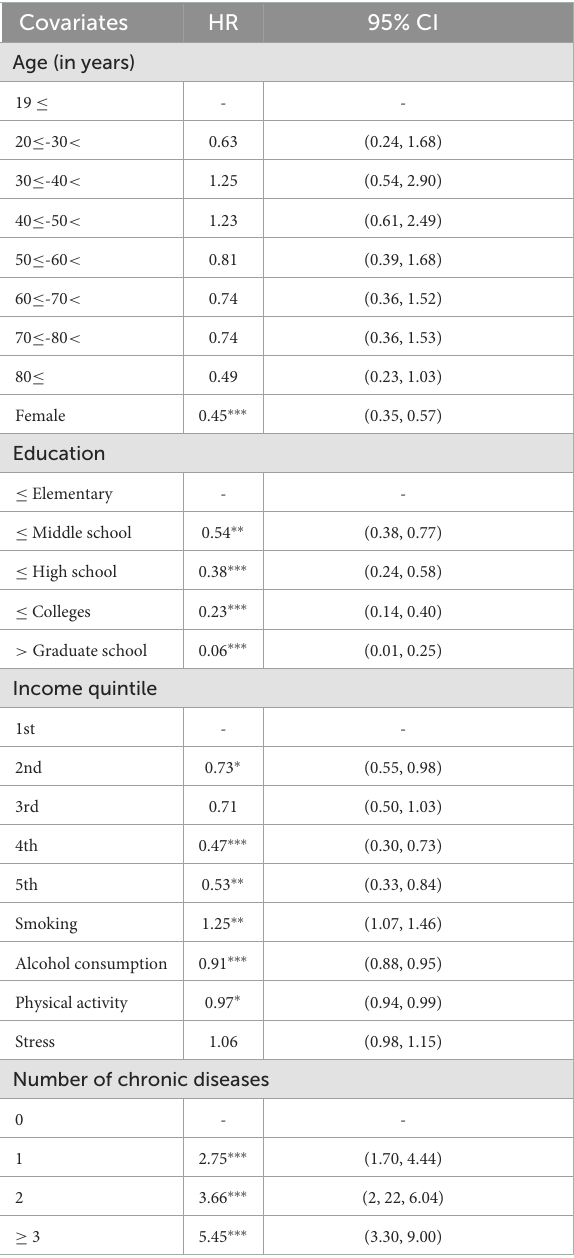
TABLE 4 Parametric survival (Weibull) regression of newly developed disability.